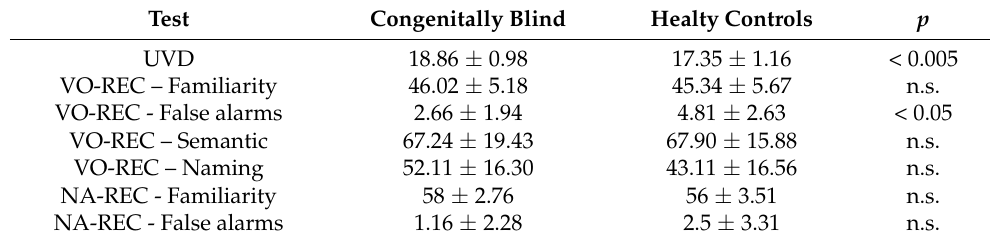
Table 2. Descripitve statistic on participants’ scores at the experimental tests. For UVD and VO-REC, adjusted scores’ mean ± SD are reported; for NA-RAC, raw scores’ mean ± SD are reported. Signifi- cant differences between the two groups are reported in bold. UVD = Unkonwn Voice Discrimination; VO-REC = Voice Recognition; NA-REC = Name Recognition; n.s. = not